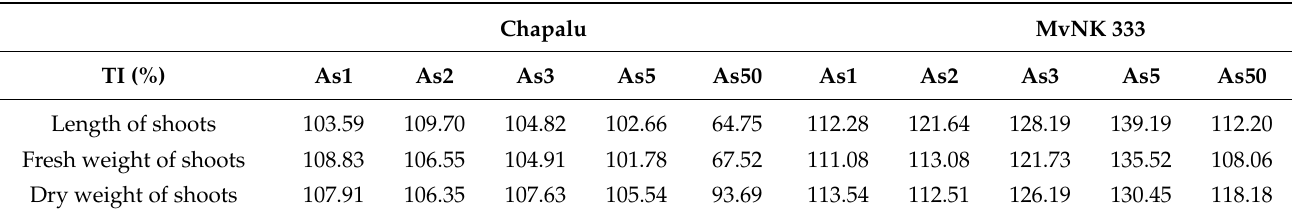
Table 1. Tolerance indexes (TI) in % determined on the basis of growth parameters of